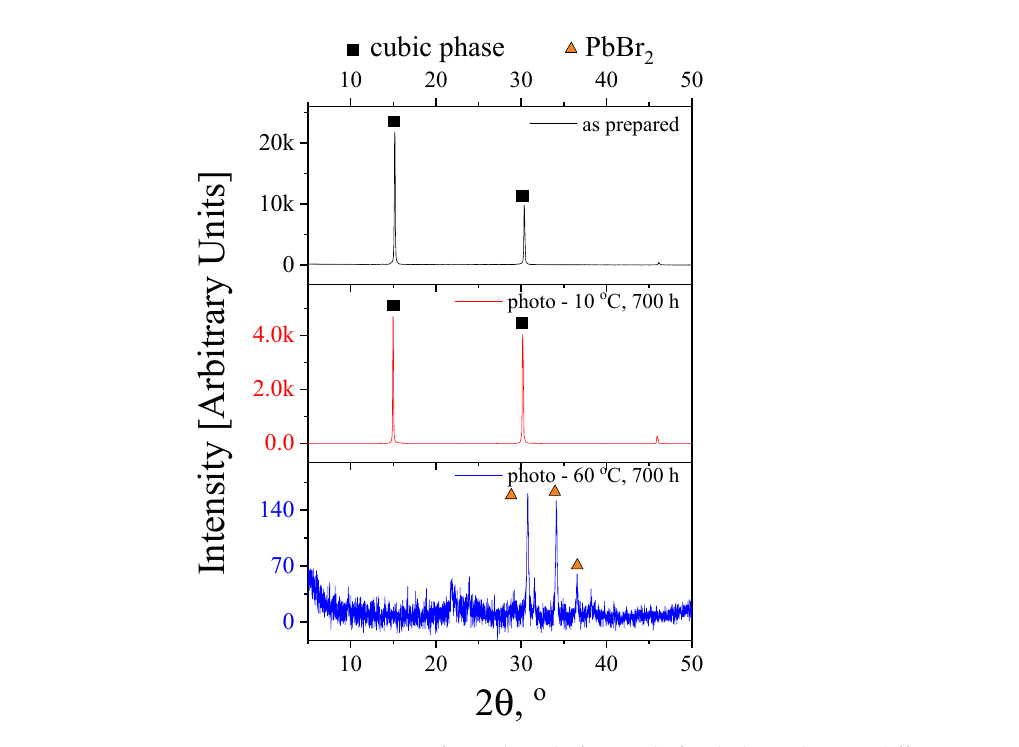
Figure 2. XRD patterns of MAPbBr 3 before and after light soaking at different temperatures.